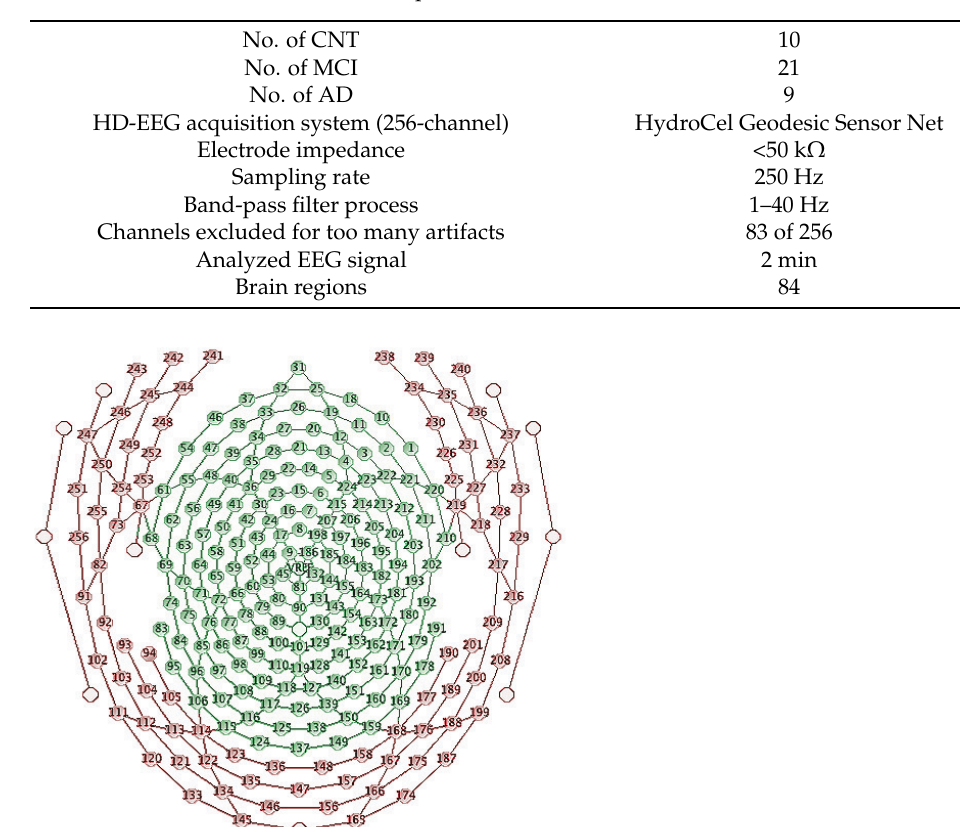
Table 1. Schematic of the main dataset parameters.